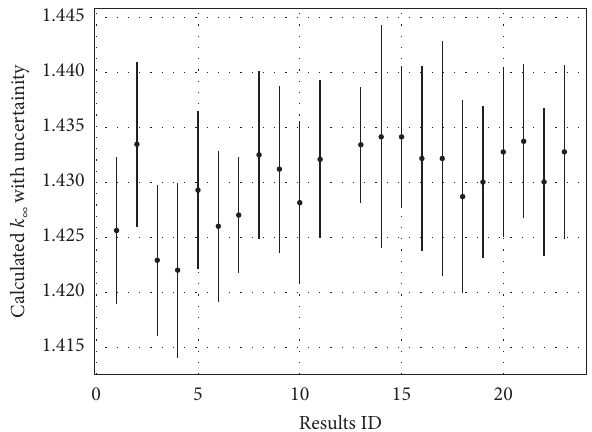
Figure 3: Mean value and uncertainty of calculated k -inf of TMI-1 HZP cell physics case.